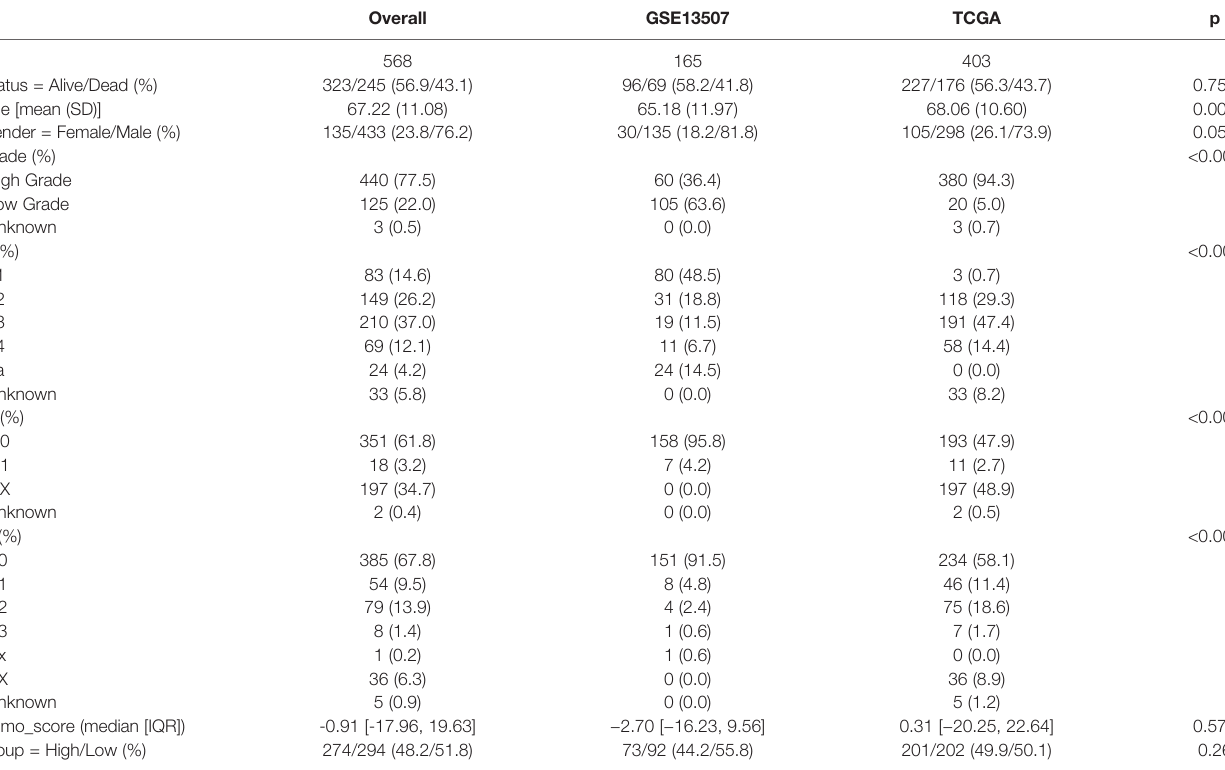
TABLE 1 | Basic characteristics of the included